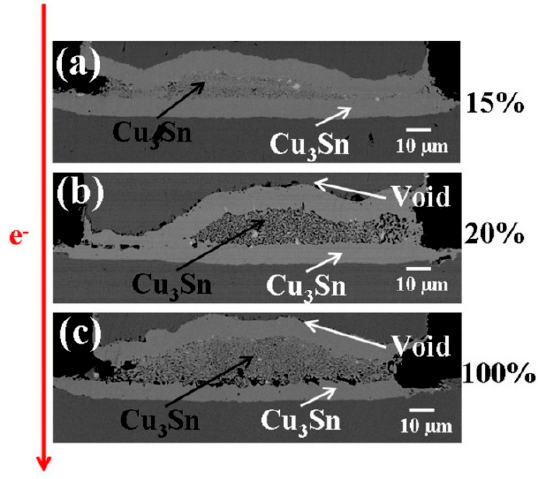
Figure 4. Cross-sectional SEM images of solder bumps with Cu column UBM stressed at 1.45 × 10 4 A/cm 2 with downward electron flow at 185 °C with bump resistance increases ( a ) 15%, ( b ) 20%, and ( c ) 100% of its initial value.